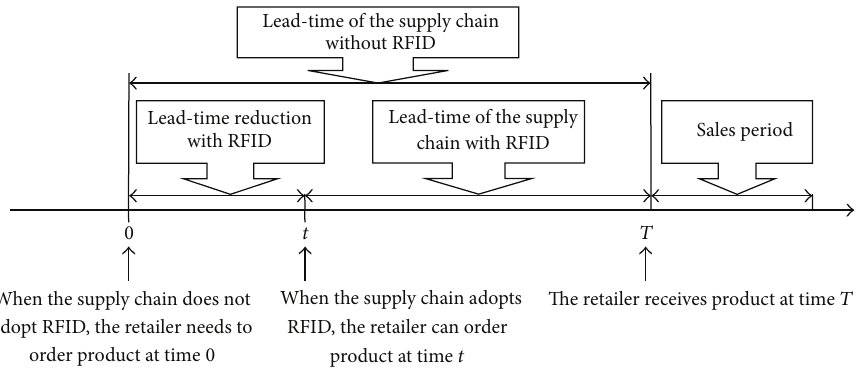
Figure 1: The lead-time reduction with adoption of RFID